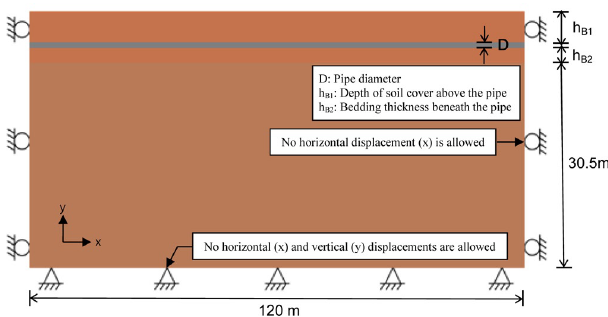
Fig. 4. Configuration of numerical model associated with pipeline and an in situ soil depth and width of 30.5 and 120m, respectively.